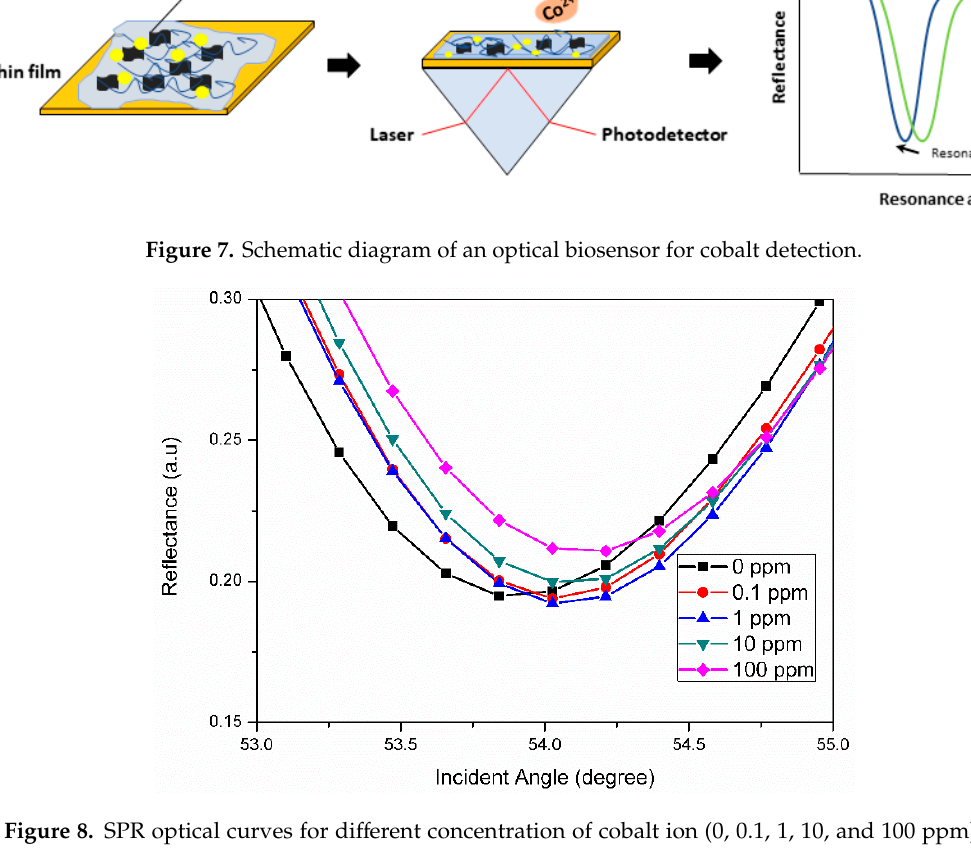
Figure 8. SPR optical curves for different concentration of cobalt ion (0, 0.1, 1, 10, and 100 ppm) in contact with the chitosan-GO-CdS QDs sensor layer.